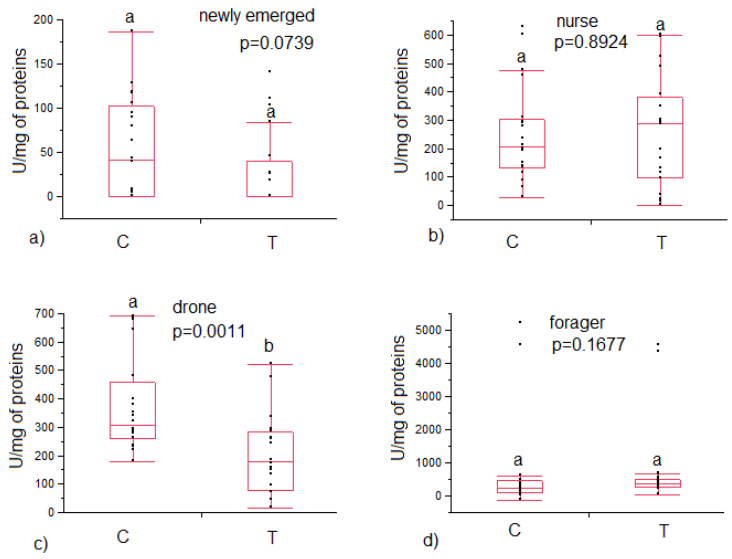
Figure 2. Glucose oxidase activity in ( a ) newly emerged, ( b ) nurse, ( c ) drone and ( d ) foragers belonging to control (C) and treated (T) colonies. Statistical differences are indicated with different letters.